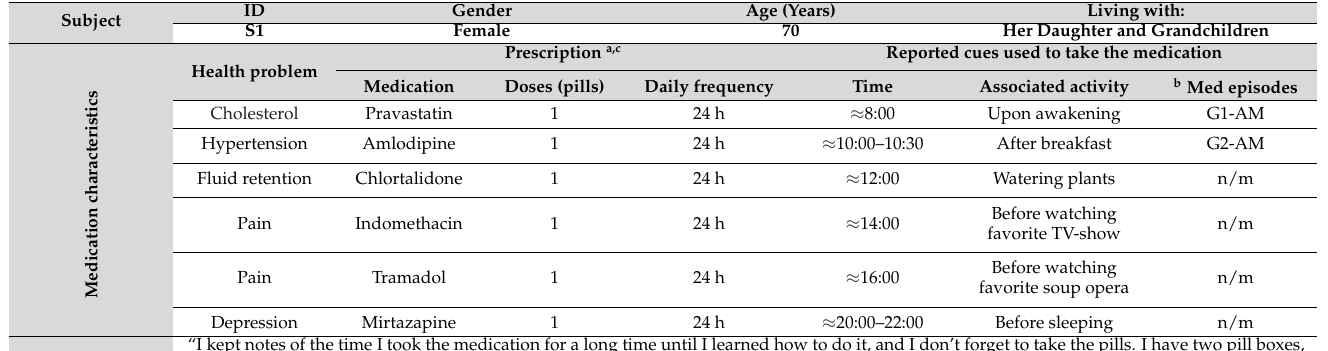
Table 3. Demographic and medication routine characteristics gathered from subject S1 during the initial